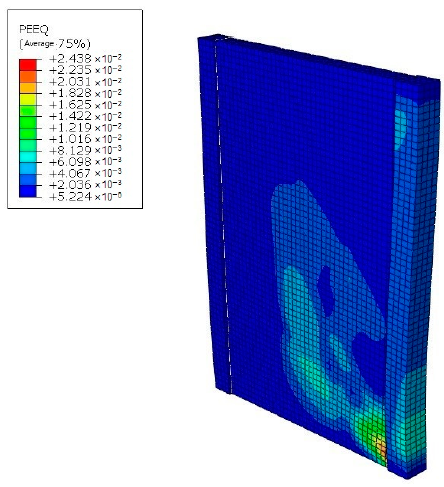
Figure 12. PEEQ of concrete for DSCW-1.